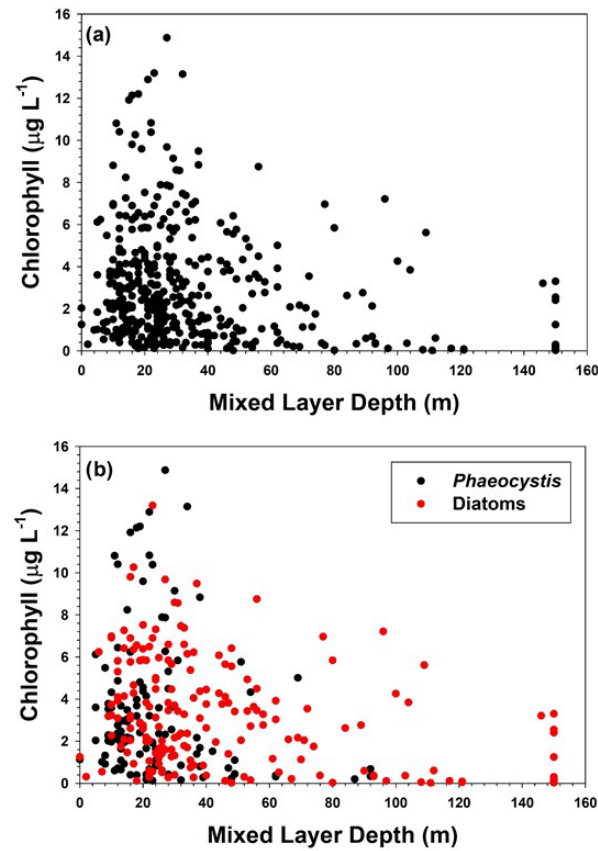
Figure 5. (a) Relationship of mixed layer chlorophyll concentra- tions with mixed layer depth, and (b) relationship of chlorophyll concentrations at stations dominated by either diatoms or Phaeo- cystis to mixed layer